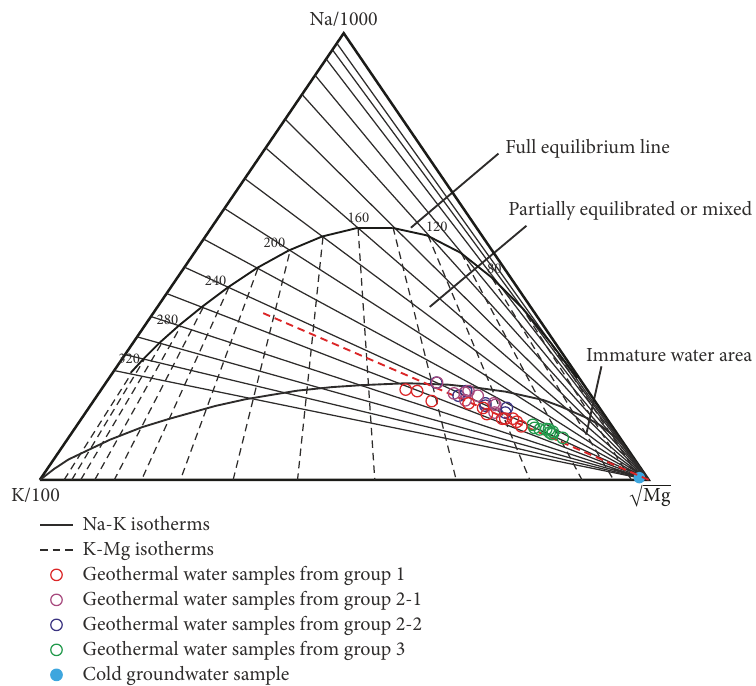
Figure 6: Na-K-Mg diagram for all the geothermal spring samples in the research area [15].